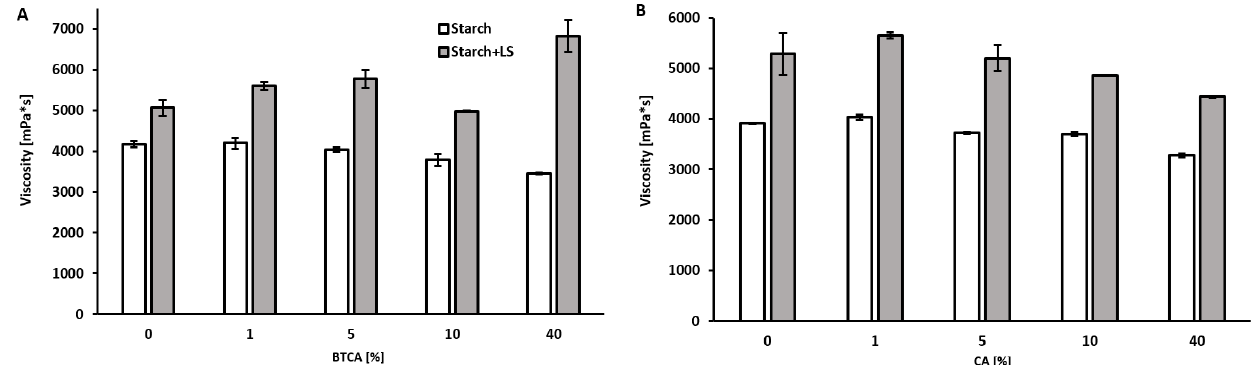
Figure 1. Viscosity of a starch-based adhesive with and without enzymatically polymerized LS (8%), and containing different amounts of BTCA ( A ) and CA ( B ). Error bars indicate the standard deviation (n = 2).